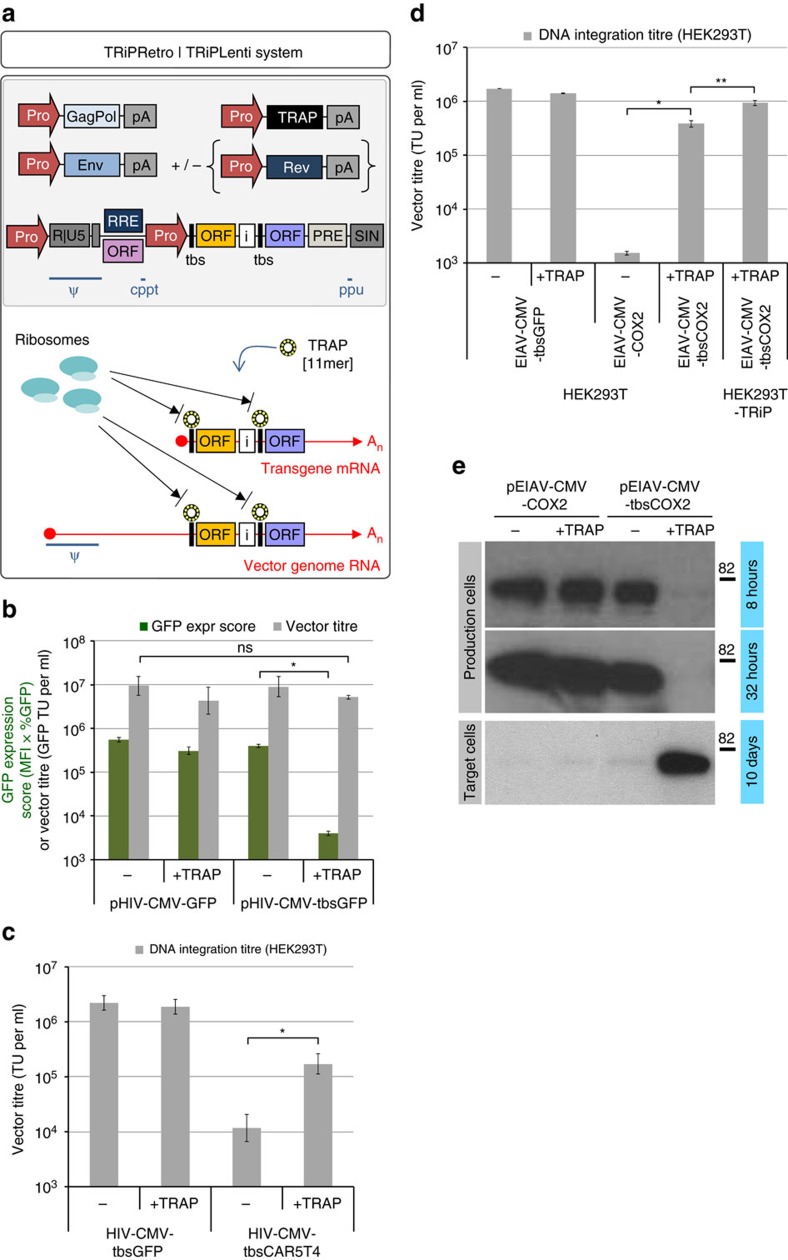
Enhanced crude titres of therapeutic lentiviral vectors using the TRiPLenti system.(a) The TRiPRetro/TRiPLenti system requires: a tbs-modified vector genome, gag/pol, envelope and TRAP expression cassettes. HIV-1-based vector systems additionally require RRE/rev for export of genomic vector RNA (vRNA), whereas Equine Infectious Anemia Virus [EIAV] vRNA can be made rev-independent by use of an upstream open-reading frame (ORF) (unpublished). The TRAP-tbs configuration is capable of repressing cap-dependent and –independent transgene expression from full length vector genome RNA and the ‘internal' transcript. (b) GFP Expression Scores in production cells (green bars) and crude vector titres on HEK293T cells (grey bars) of GFP-expressing HIV-1-based vectors. Data are mean average values±s.d. [log10-transformed data] (n=3); *P<3.2 × 10−6, nsP<0.17 [Welch's t-test]. (c) DNA-integrating titres of HIV-CMV-tbsCAR5T4 and HIV-CMV-tbsGFP vectors produced±TRAP in HEK293T cells. Data are mean average values±s.d. [log10-transformed data] (n=4); *P<4.2 × 10−4 [Welch's t-test]. (d) DNA-integrating titres of EIAV-based vectors produced±TRAP in HEK293T cells; EIAV-CMV-COX2 and EIAV-CMV-tbsCOX2 vectors were made without or with TRAP respectively, representing standard versus ‘transient' TRiPLenti protocols. EIAV-CMV-tbsCOX2 vector was additionally made in cells stably expressing TRAP, representing the ‘stable' TRiPLenti protocol. Data are mean average values±s.d. [log10-transformed data] (n=3); *P<1.3 × 10−5, **P<3.2 × 10−4 [Welch's t-test]. (e) HEK293T cell lysates from EIAV-CMV-[±tbs]COX2 vector production, as well as end-of-integration assay cell lysates, were analysed by immunoblotting to COX-2 (molecular weight marker in kilodaltons). (Pro, promoter; Ext Pro, external promoter; Int Pro, internal promoter; polyA, polyadenylation signal; Ψ, packaging signal; RRE, rev-responsive element; cppt, central polypurine tract; tbs, TRAP-binding sequence; IRES, internal ribosomal entry site (encephalomyocarditis virus); PRE, post-transcriptional regulatory element; ppu, polypurine tract; SIN, self-inactivating; An, poly-adenines). Results are representative of two independent experiments.